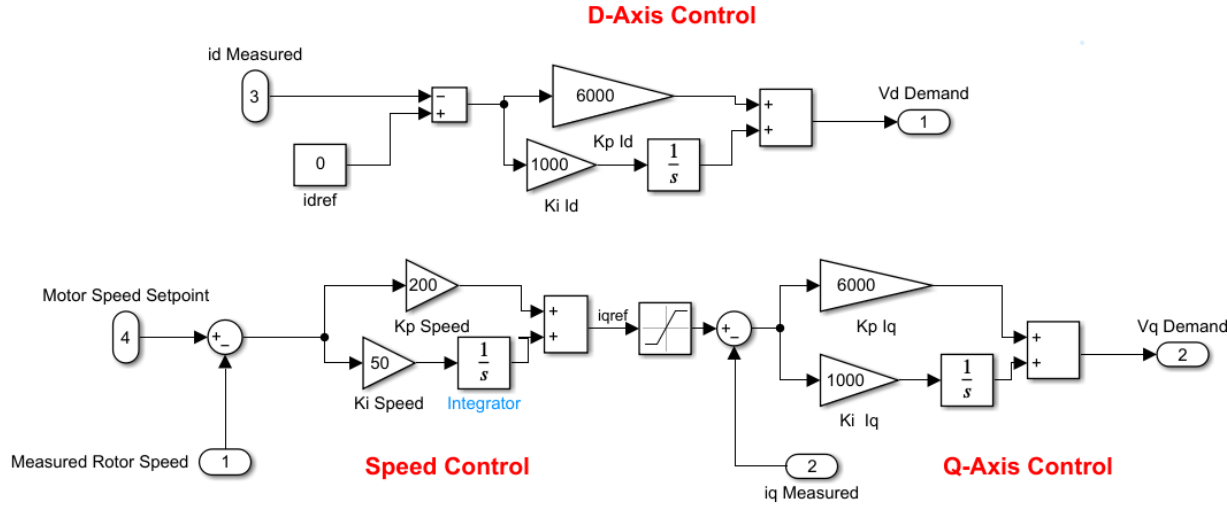
Figure 5. Cascade control of PMSM current.